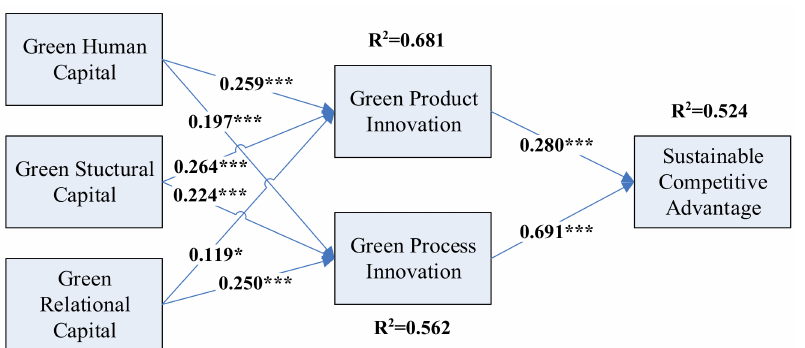
Figure 2. The impact of green intellectual capital on competitive advantage. Note: * Significant at p < 0.05 (two-tailed); *** Significant at p < 0.001 (two-tailed). The relationships between variables con- nected by dotted lines were not significant. Standardized solution, n = 341. Model fit: χ 2 (251) = 589.5, comparative fit index (CFI) = 0.995, Root Mean Square Error of Approximation (RMSEA) = 0.014 (90% confidence interval: 0.001–0.023), goodness-of-fit index (GFI) = 0.921, non-normed fit index (NNFI) = 0.994, standardized root mean square residual (SRMR) =